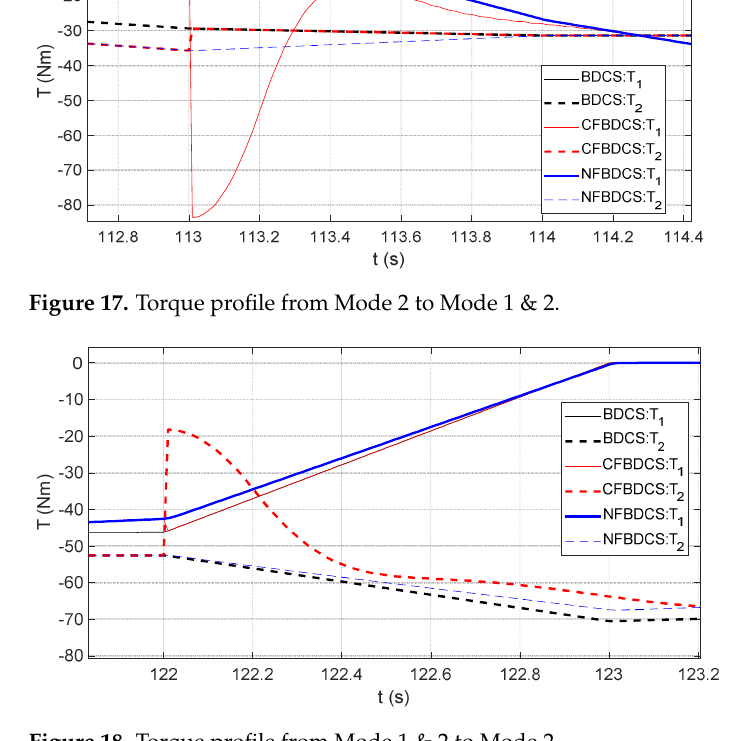
Figure 18. Torque profile from Mode 1 & 2 to Mode 2.